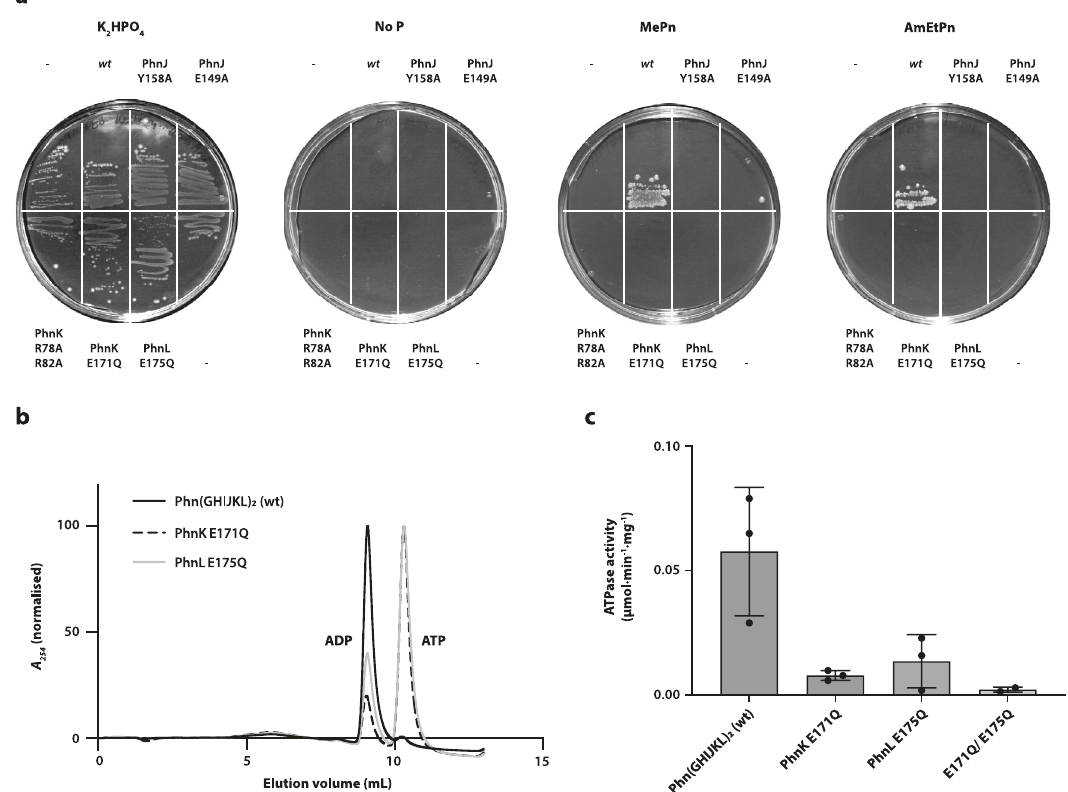
Fig. 3 | ATP hydrolysis by PhnK and PhnL is required for phosphonate utilisa- tion in vivo. a In vivo functional assay using the E. coli HO1488 strain ( Δ phnHIJKLMNOP ) grown either without plasmid ( − ) or complemented with pSKA03containing the entire phn operon includingthe pho box and including the following speci fi c mutations: wt(none),PhnJ Y158A, PhnJ E149A,PhnK R78A/R82A, PhnK E171Q, and PhnL E175Q. Cells were plated on MOPS minimal agar plates 44 containingeitherK 2 HPO 4 ,2-AmEtPn,MePn,ornoaddedphosphorussource(noP) as indicated. The plates are representative of two repetitions. Source data are provided as a Source Data fi le. b ATPase activity using puri fi ed Phn(GHIJKL) 2